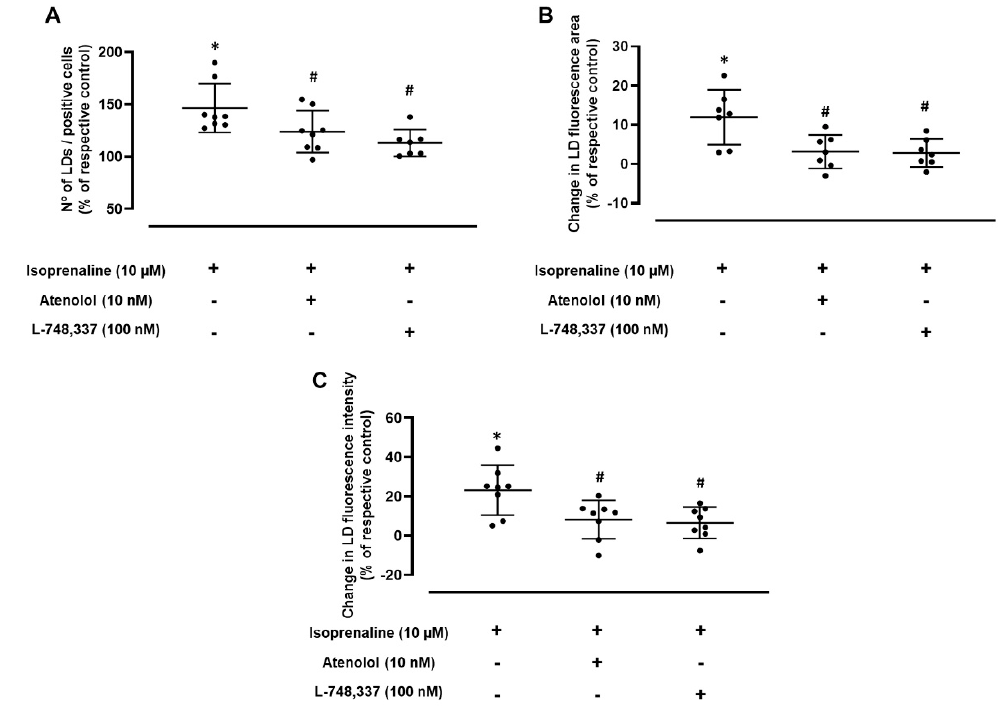
Figure 3. Influence of the selective β 1 -adrenergic receptor antagonist atenolol (10 nM) and the selective β 3 -adrenergic receptor antagonist L-748,337 (100 nM) on the effect caused by isoprenaline (10 µ M) on ( A ) the number of lipid droplets (LDs)/positive cells, ( B ) their area and ( C ) their Nile Red fluorescence intensity after 72 h of incubation. Results are expressed as percentage of control (solvent) and are presented as mean ± SD from 7 − 8 independent experiments. * p < 0.05, significantly different from solvent; # p < 0.05, significantly different from isoprenaline treatment.